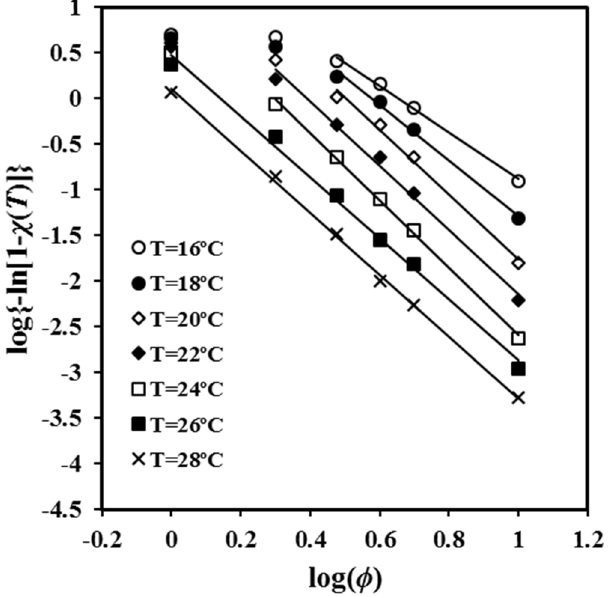
Figure 3. Plots of log{ − ln [1 − χ ( T )]} versus log ϕ for non-isothermal crystallizations of P4HB at the indicated temperatures.